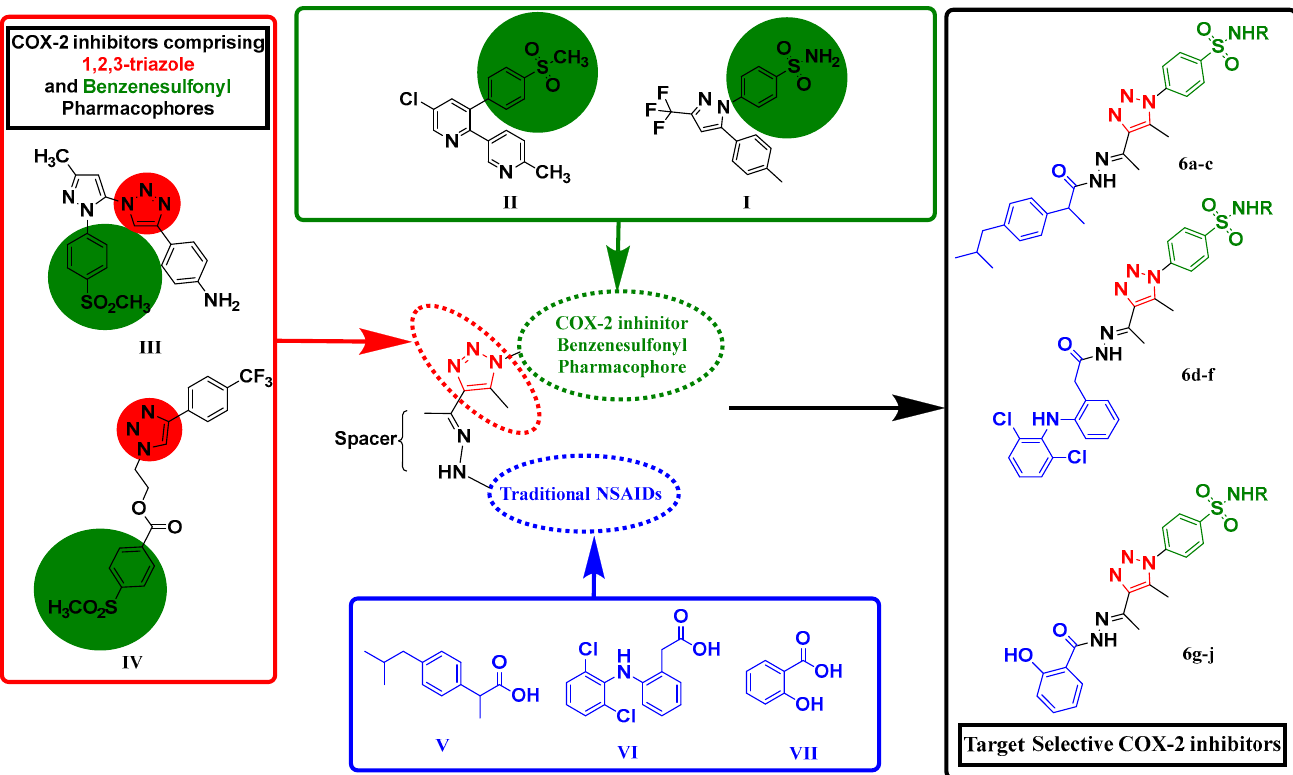
Figure 1. Rational design of the target selective COX-2 inhibitors.